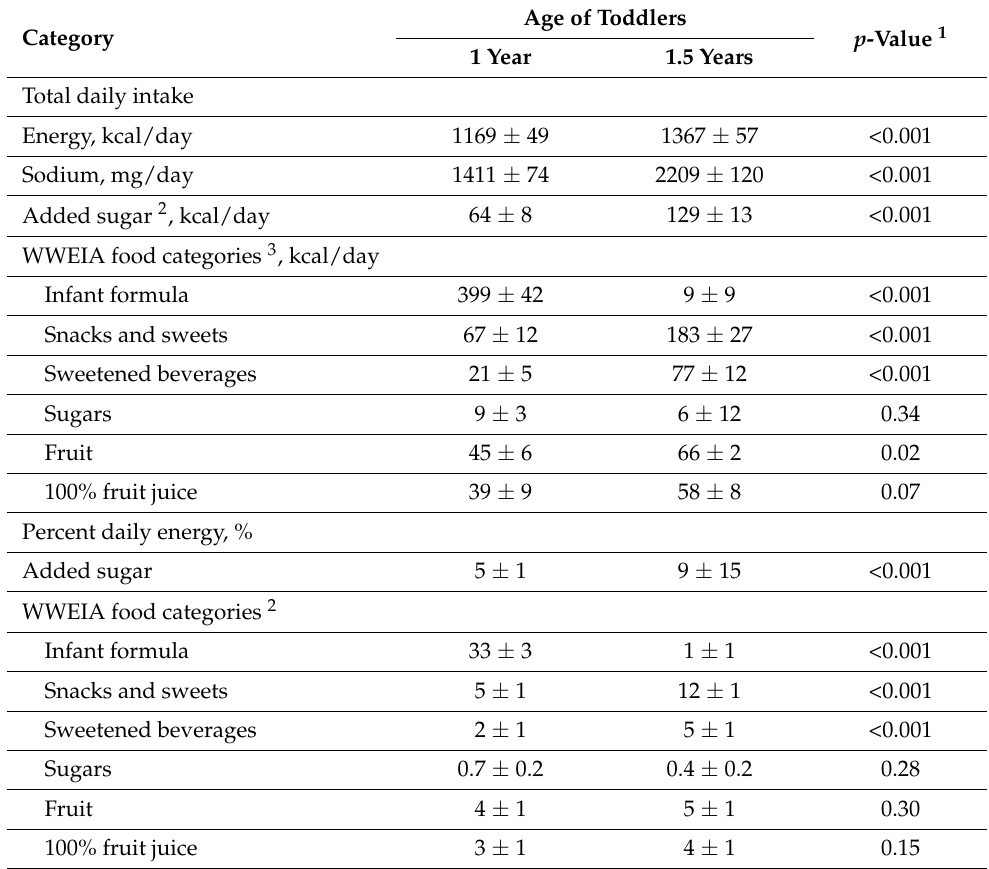
Table 3. Mean daily intake and percent (%) daily energy by food category at 1 and 1.5